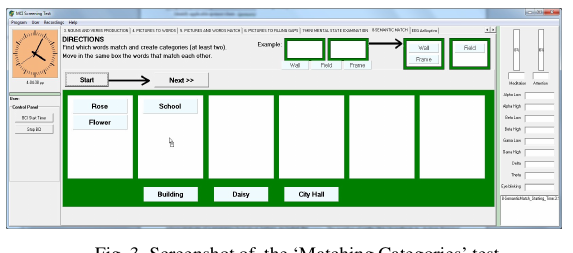
Fig. 3. Screenshot of the ‘Matching Categories’ test MCI patients were expected to face difficulties in